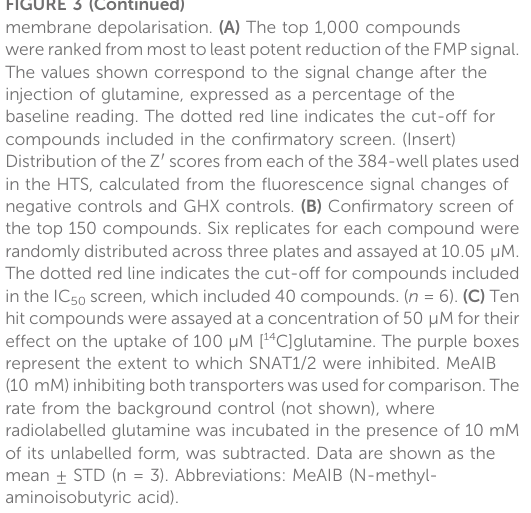
wererankedfrommosttoleastpotentreductionoftheFMPsignal. The values shown correspond to the signal change after the injection of glutamine, expressed as a percentage of the baseline reading. The dotted red line indicates the cut-off for compounds included in the con fi rmatory screen. (Insert) Distribution of theZ ′ scores fromeach of the384-well plates used in the HTS, calculated from the fl uorescence signal changes of negative controls and GHX controls. (B) Con fi rmatory screen of the top 150 compounds. Six replicates for each compound were randomly distributed across three plates and assayed at 10.05 µM. The dotted red line indicates the cut-off for compounds included in the IC 50 screen, which included 40 compounds. ( n = 6). (C) Ten hit compounds were assayed at a concentration of 50 µM for their effect on the uptake of 100 µM [ 14 C]glutamine. The purple boxes represent the extent to which SNAT1/2 were inhibited. MeAIB (10 mM)inhibitingbothtransporterswasusedforcomparison.The rate from the background control (not shown), where radiolabelled glutamine was incubated in the presence of 10 mM of its unlabelled form, was subtracted. Data are shown as